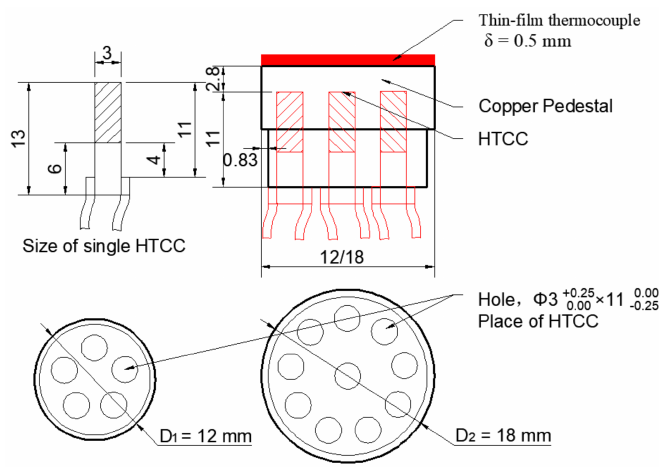
Figure 3. Schematic diagram of Heat source simulation